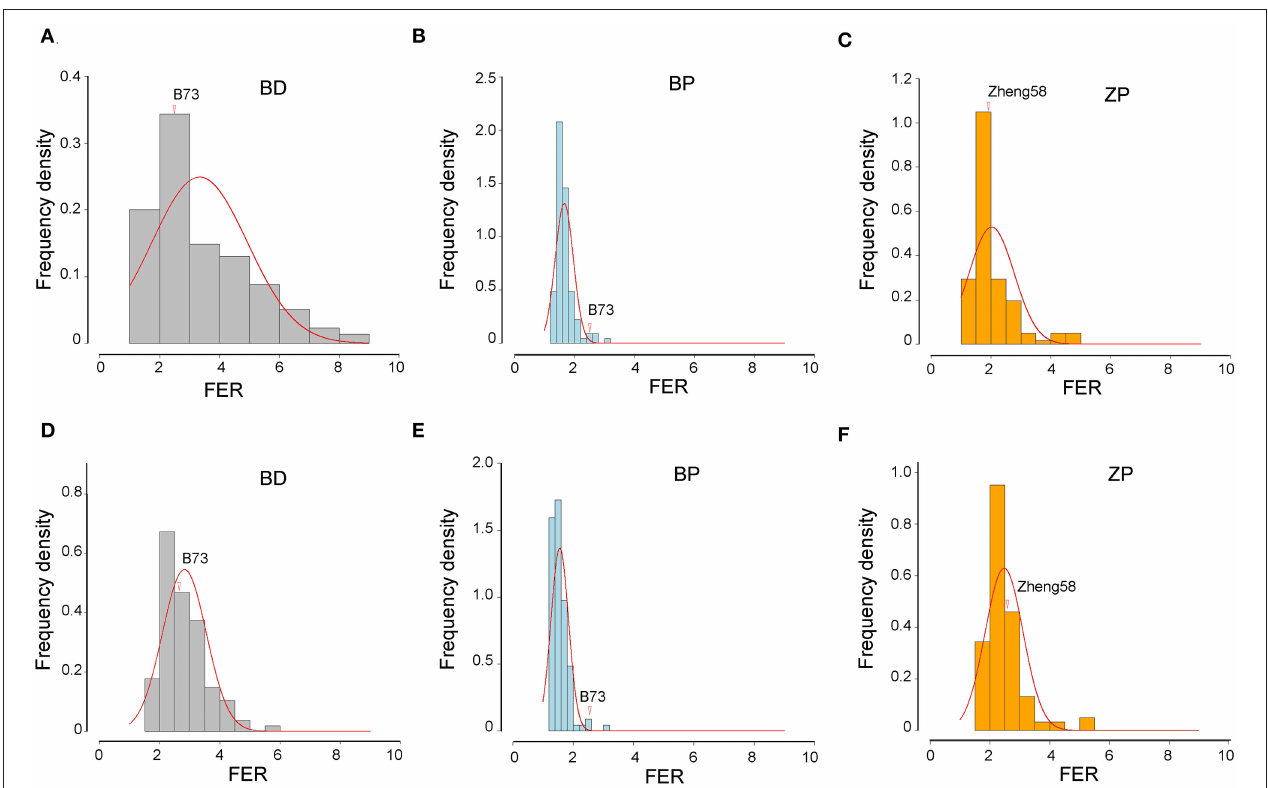
FIGURE 2 | Frequency distribution of FER in three populations. (A–C) The data of 2021 in Chongzhou. (D–F) The data of 2022 in Xishuangbanna. The vertical axis shows the frequency density. The horizontal axis represents the FER. Frequency = “frequency density” × “FER spacing.” Red lines represent normal distribution fitting curve of each population. The FER of maize parents are indicated by red arrows. The BLUP value of FER from three replicates of each environment was used